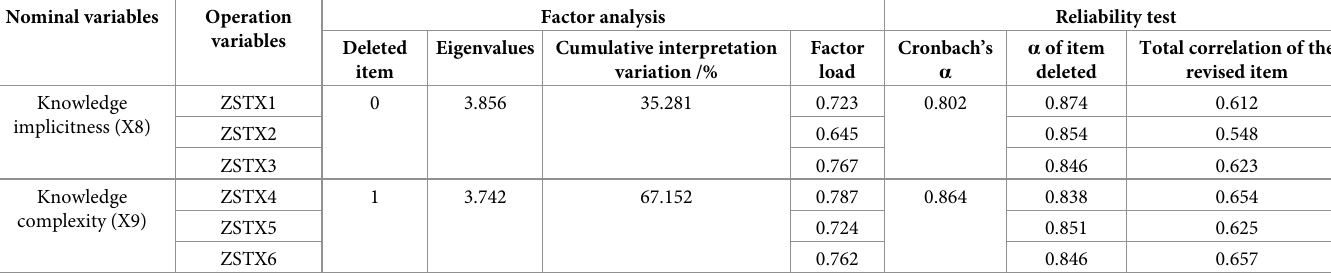
Table 9. Factor analysis and reliability test scale results regarding transferred knowledge.